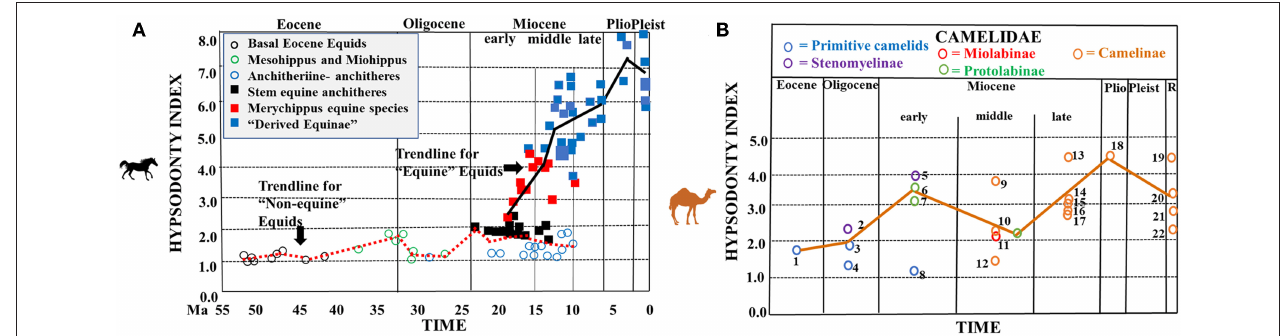
FIGURE 2 | Hypsodonty indices of fossil equids and camelids. (A) Hypsodonty indices of North American fossil equids and Recent Old World equids (modified from Figure 2 in Damuth and Janis, 2011). Key to taxa: open circles = basal Eocene equids ( Epihippus , Hyracotherium , Orohippus ); Mesohippus and Miohippus , and Anchitherini; ( Anchitherium , Hypohippus , Kalobatippus , Megahippus ); squares = stem equine anchitheres ( Archaeohippus , Desmatippus , Parahippus ); Merychippus equine species; and “Derived Equinae.” Average modern (Recent) Equus hypsodonty indices from Janis (1988). The red, dotted line represents the hypsodonty index trendline for non-equine equids; the black, solid line represents the hypsodonty index trendline for equine equids (B) . Hypsodonty indices of North American fossil camelids through time (brown, solid line represents the trendline through time -modified from Figure 4A in Semprebon and Rivals, 2010). Key to taxa: blue circles = primitive camelids (1 = Poebrotherium eximus , 3 = Poebrotherium wilsoni , 4 = Poabromylus kayi , 8 = Paratylopus cameloides ); purple circles = Stenomyelinae (2 = Pseudolabis dakotensis , 5 = Stenomylus hitchcocki ); red circles = Miolabinae (11 = Miolabis longiceps ); green circles = Protolabinae (6 = Protolabis sp., 7 = Michenia sp.); orange circles = Camelinae (9 = Procamelus sp., 10 = Aepycamelus sp., 12 = Aepycamelus stocki , 13 = Procamelus occidentalis , 14 = Megatylopus gigas , 15 = Procamelus sp., 16 = Hemiauchenia sp., 17 = Aepycamelus sp., 18 = Camelops mexicanus , 19 = Lama vicugna , 20 = Lama guanicoe , 21 = Camelus bactrianus , 22 = Camelus dromedaries ) Locality information for numbered taxa as in Table 1 in Semprebon and Rivals (2010). Please note that hypsodont equids will likely always have higher hypsodonty indices than ruminants on a similar diet, due to differences in digestive physiology and ingestive